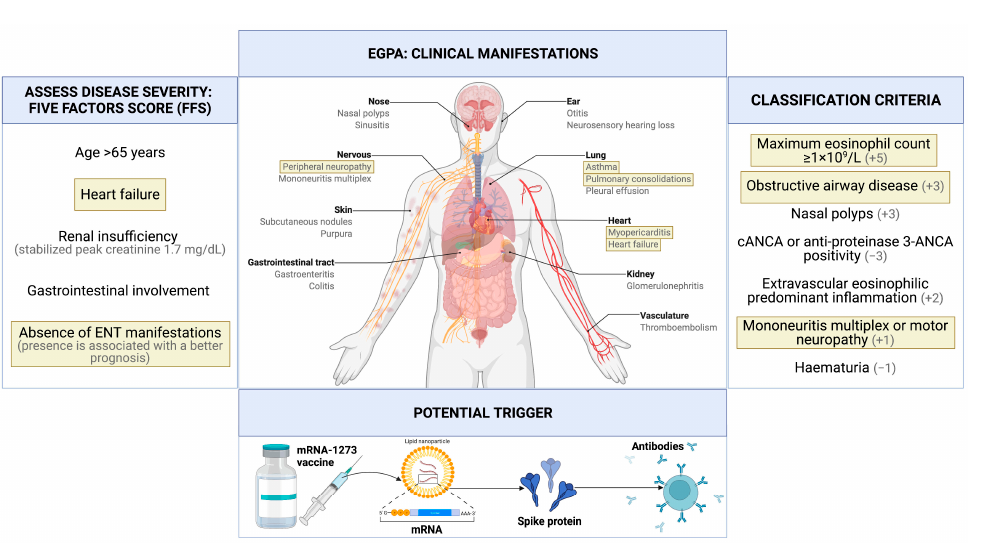
Figure 2. Blood parameters of disease activity in our patient at four timepoints. Notably, blood eo- sinophils were found to be within the normal range some years previously (in 2018) and also during the worsening of asthma which occurred after the first two vaccine shots and apparently were ele- vated only once EGPA was manifest.